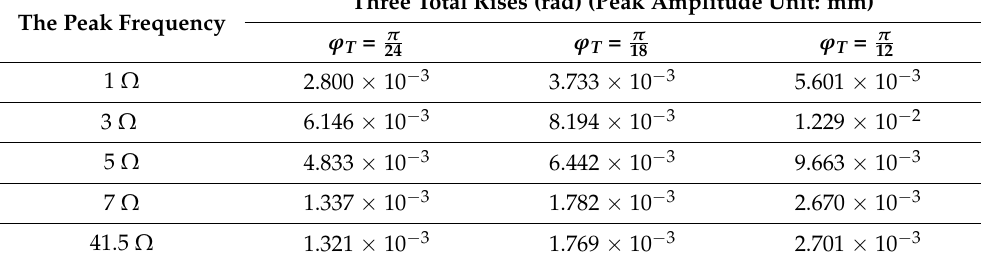
Table 7. The peak amplitude of the lateral vibration spectrum of the follower output node D where Ω = 320 rad/s and with three total rises. The Peak